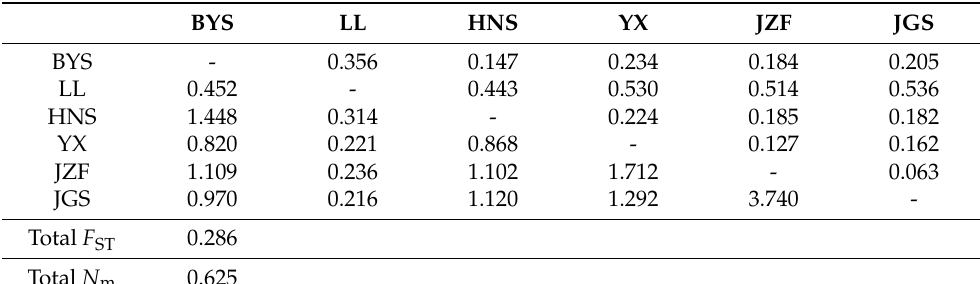
Table 5. Pairwise population genetic differentiation index ( F ST ) (above diagonal) with all significant population differentiation where p < 0.01 and number of migrants per generation ( N m ) (below diagonal) among populations of S. tzumu